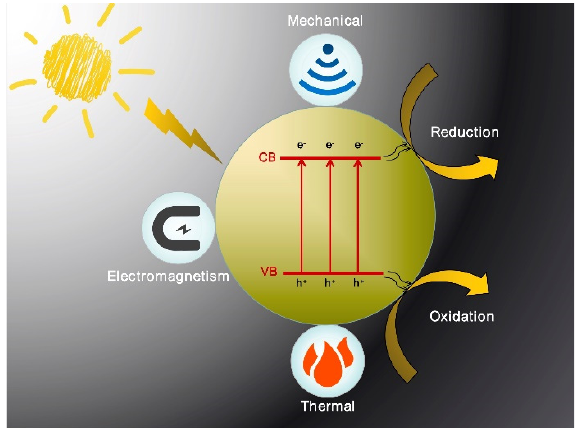
Figure 1. Schematic diagram of three types of external field-assisted photocatalysis.